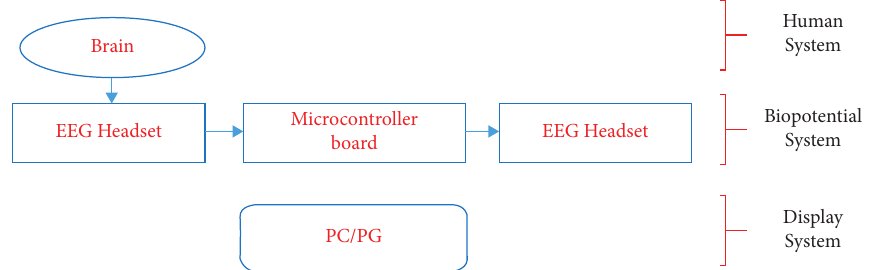
Figure 12: Schematic of the EEG-controlled prosthesis.